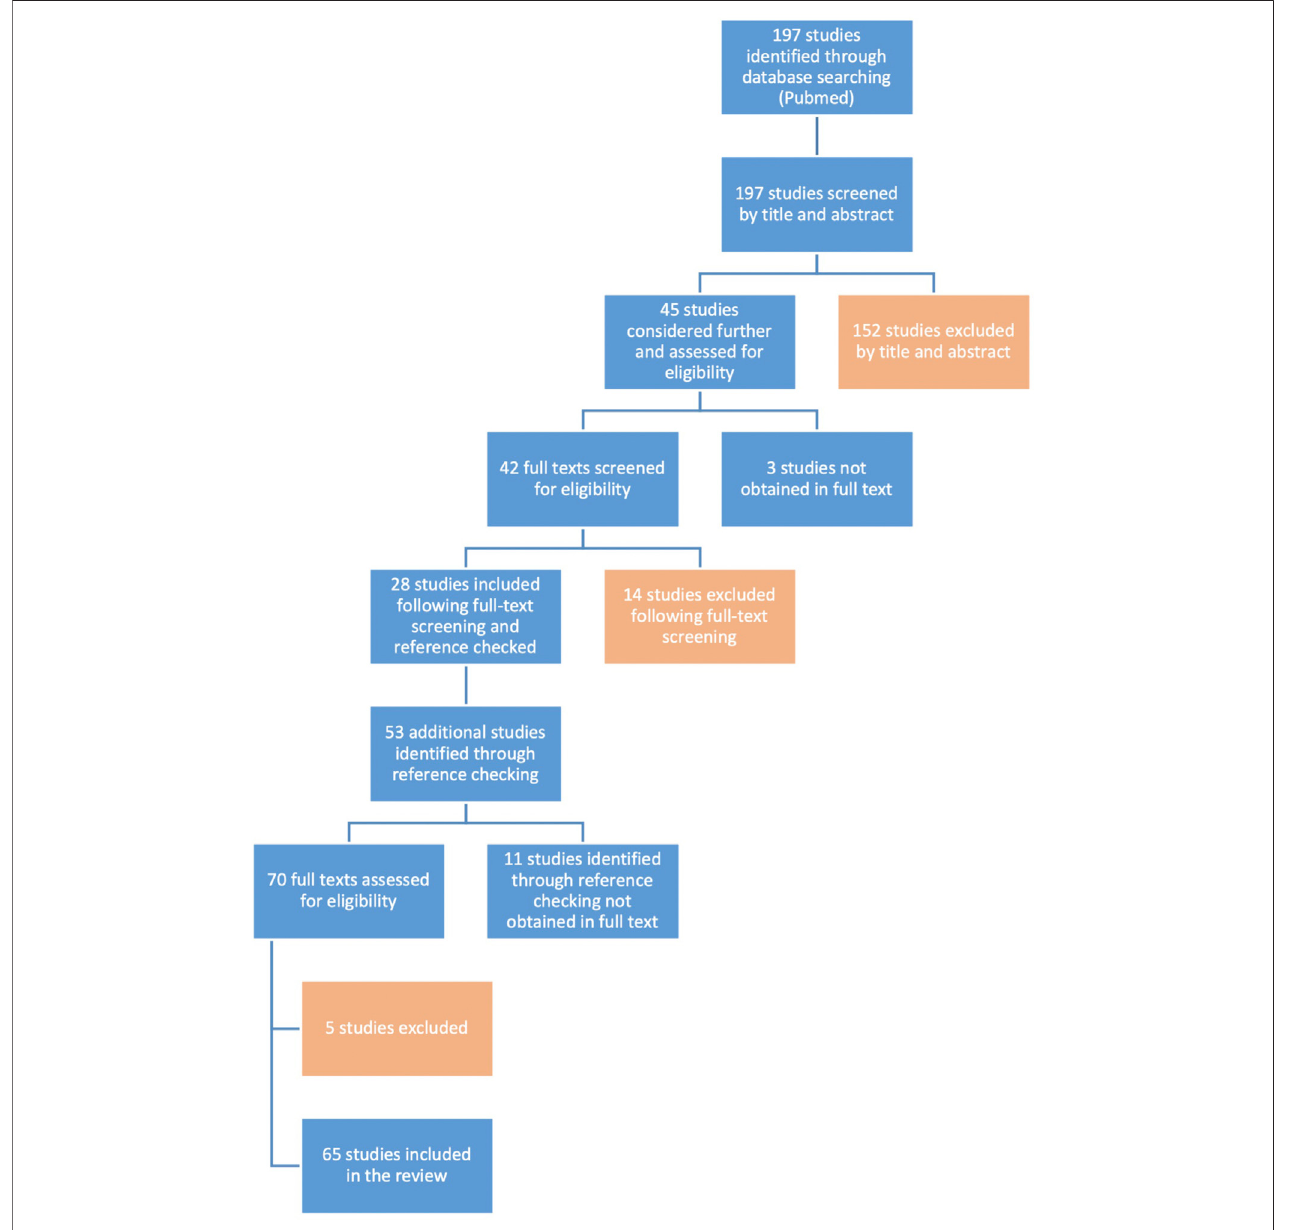
FIGURE 1 | Flow diagram. Visualization of the literature search and the study selection process according to the PRISMA-ScR guidelines.